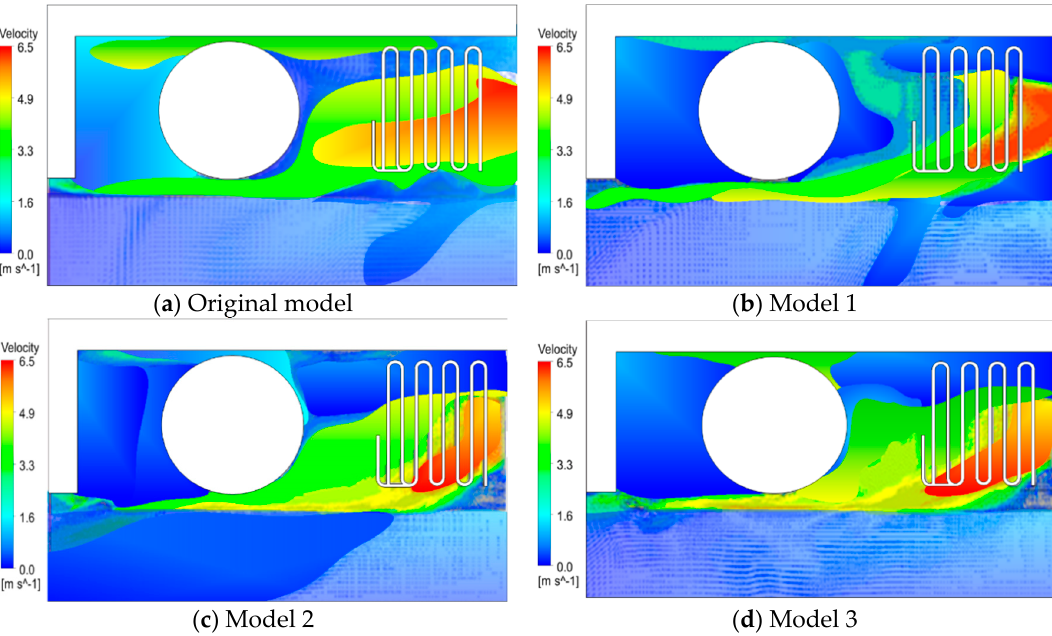
Figure 18. Velocity plots of horizontal section at − 40 mm position from the center—top view.